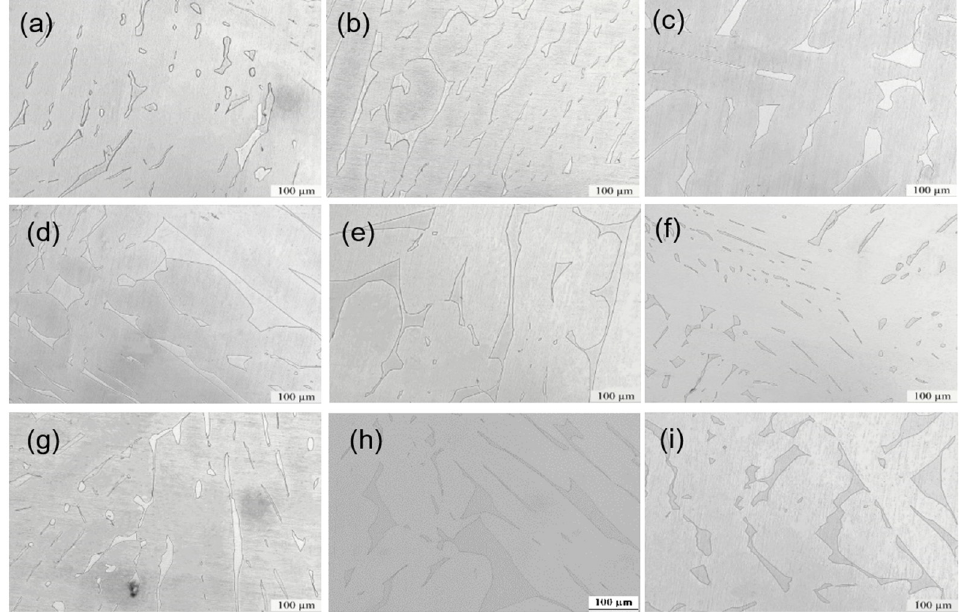
Figure 3. Microstructures of Z3CN20-09M cast stainless steel after different amounts of aging: ( a ) 0 h, ( b ) 272 h, ( c ) 544 h, ( d ) 1000 h, ( e ) 2000 h, ( f ) 3000 h, ( g ) 6000 h, ( h ) 10,000 h, ( i ) 15,000 h.